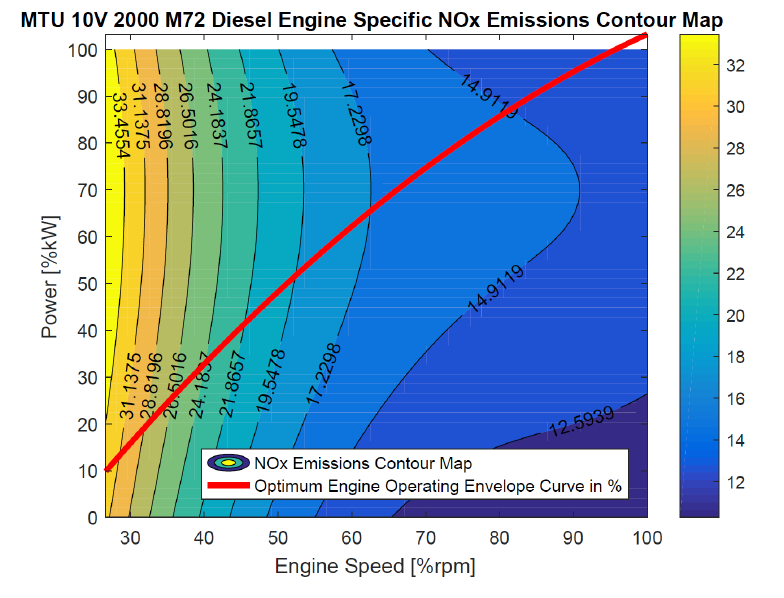
Figure 12. MTU 10V 2000 M72 diesel engine-specific NOx emissions contour